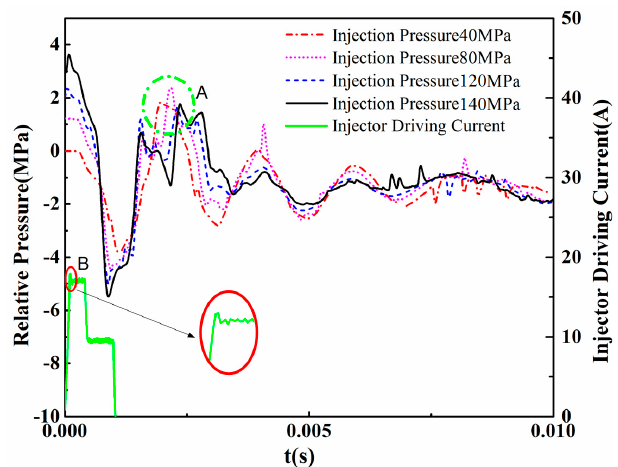
Figure 13. Off-delay characteristics of the injector.